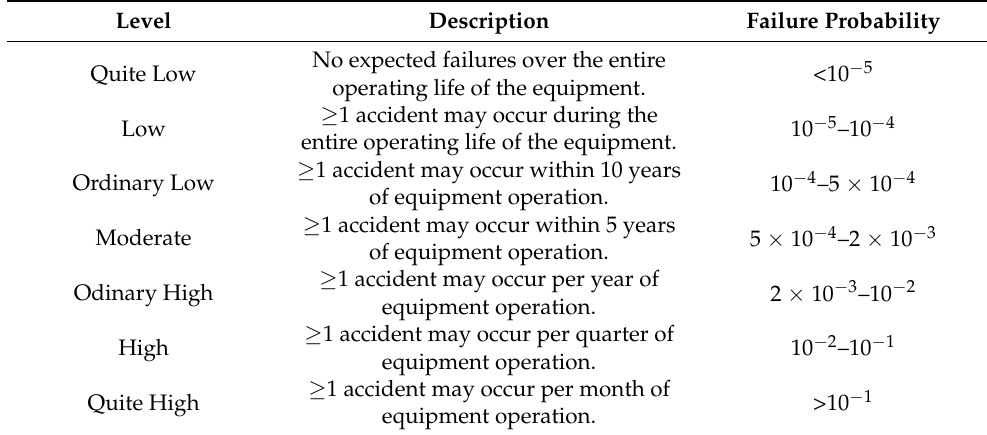
Table 5. Failure-probability rating of the coal gasifier.